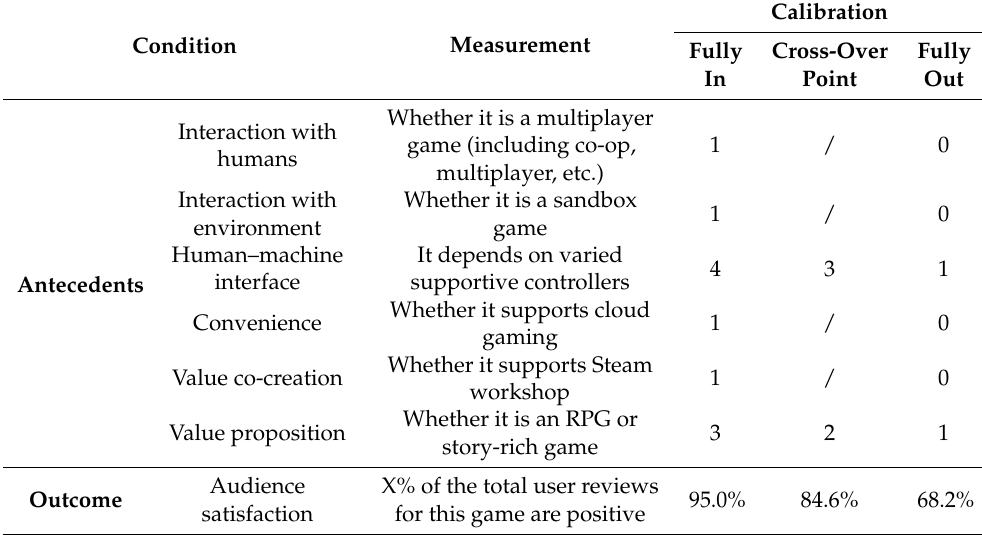
Calibration Fully Cross-Over Fully In Point Out